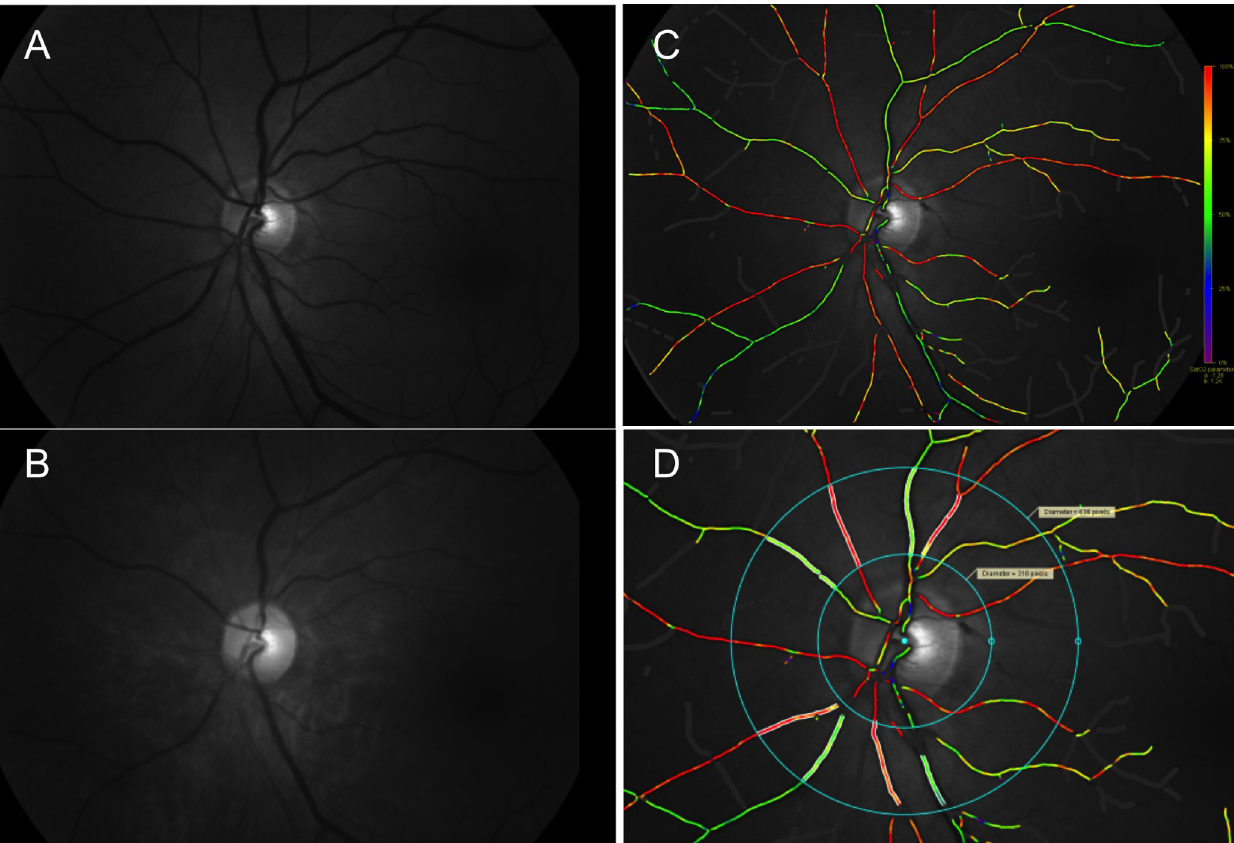
Fig 1. Fundus images at two different wavelengths of light obtained by Oxymap T1 and the oxygen saturation map analyzed by Oxymap Analyzer. ( A , B ) Oxymap T1 simultaneously captures 50° monochrome images centered at the optic disc at two different wavelengths of light (570 nm and 600 nm). ( A ) 570 nm is the reference isosbestic wavelength that is insensitive to oxygen concentration. ( B ) 600 nm is the oxygen-sensitive wavelength. ( C ) Oxymap Analyzer automatically calculates the oxygen saturation in each selected vessel and produces a color oxygen saturation map. Retinal vessels with higher oxygen saturation are indicated with red to orange color. Green to purple color indicates the retinal vessels with lower oxygen saturation. ( D ) For the analysis, vessel selection was performed disc-centered, 1.5-to 3-disc diameters area and 1 disc diameter away from the disc